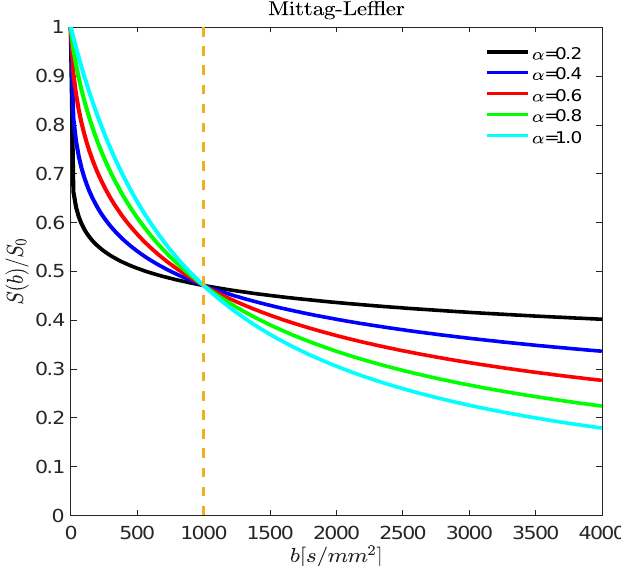
Figure 4. The normalized stretched Mittag-Leffler signal decay of S(b)/S 0 is plotted versus b -values between 0 and 4000 s/mm 2 , with D 0 = 1 × 10 −3 mm 2 /s. Five values for α = 0.2, 0.4, 0.6, 0.8, and 1.0 are displayed. The last value in this sequence, corresponding to α = 1, gives the single exponential function. As the value of α decreases, the shape of the decay curve transitions from stretched exponential to an asymptotic power law decay.